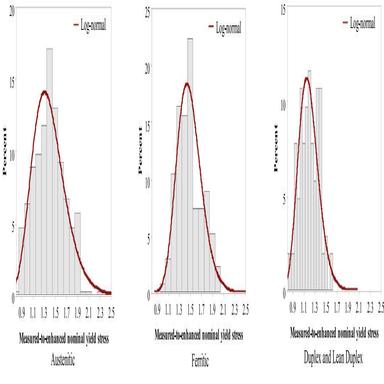
Histograms of yield stress fy for different cold-formed stainless steel types.